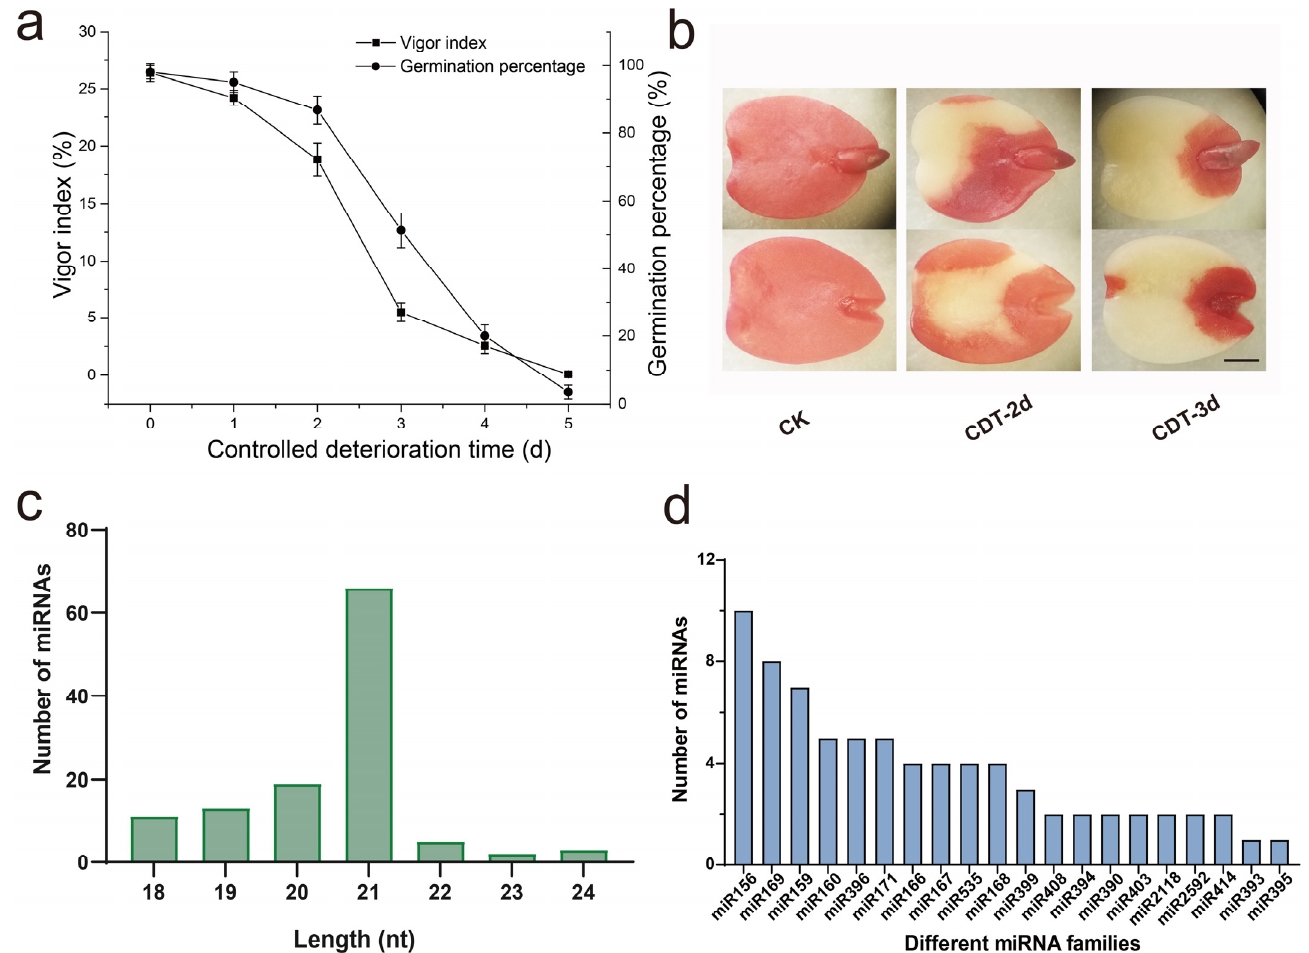
Figure 1. Small RNA profiles and miRNAs identification in aged elm seeds. ( a ) Effects of controlled deterioration treatment (CDT) on germination and the vigor index of elm seeds. ( b ) TTC staining of elm seeds after CDT. The TTC stained cotyledons were observed by micrographs. Control check seeds (CK), seeds aged for two days (CDT − 2d), and for three days (CDT − 3d) were used for multi-omic analysis. Scale bar = 1 mm. ( c ) Length distribution of the miRNA sequences in the miRNAome. The abscissa represents the length of the mature miRNAs, and the ordinate represents the number of miRNAs contained in each length of the miRNA. Nt, nucleotide. ( d ) The count of the top 20 miRNA family. The abscissa represents names of different miRNA families, and the ordinate represents the number of members contained in each miRNA family.